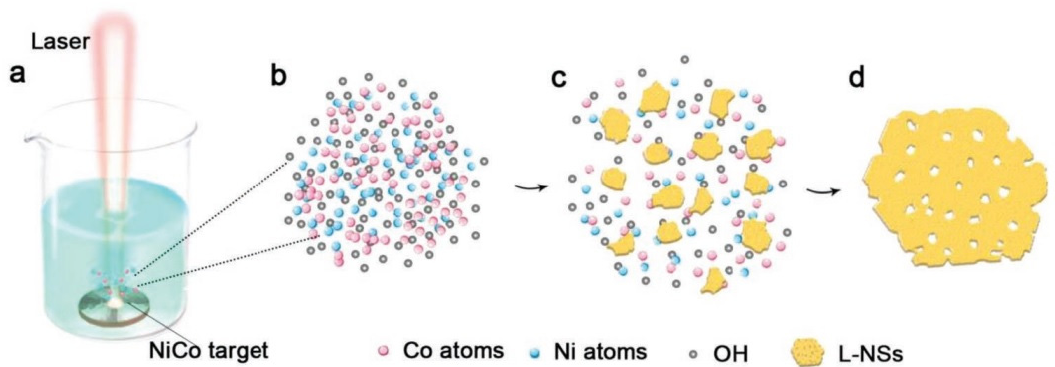
Figure 10. The formation of L ‐ NSs. ( a ) Laser ablation of CoNi alloy target in 1 m KOH solution, ( b ) mixed vapor of cobalt, nickel, and OH − , ( c ) formation of hydroxide debris in the vapor, ( d ) formation of L ‐ NSs via orientation attachment. Reprinted with permission from Wang et al. [93]. Copyright 2019: Wiley.